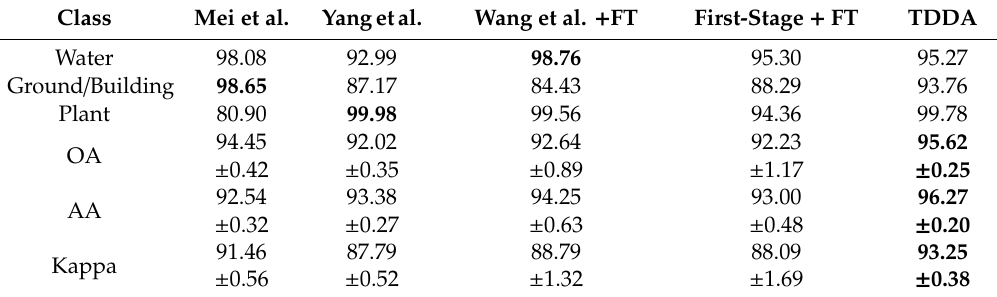
Table 9. Classification accuracy and kappa (%) on Hangzhou → Shanghai